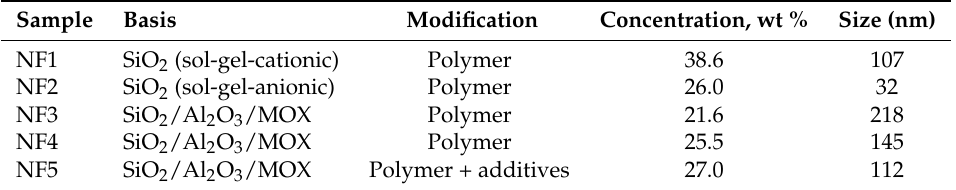
Figure 2. Concentrated solutions of hydrophilic silica nanoparticles as received from Evonik Industries; from left to the right: NF1, NF2, NF3, NF4 and NF5. Table 1. Properties of the nanoparticles suspended in distilled water.